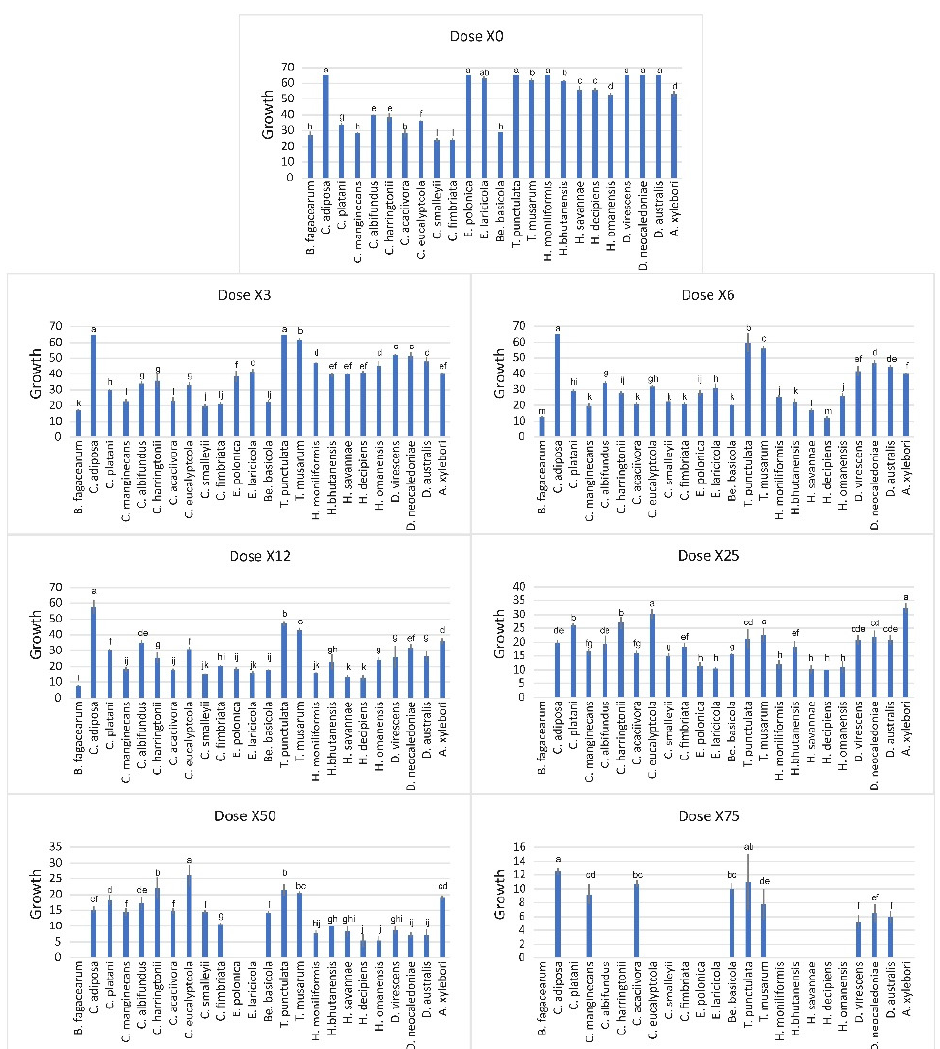
Figure 6. Effect of different triazole concentrations on mycelial growth of different Ceratocystidaceae including Ceratocystis ( C. manginecans , C. fimbriata , C. eucalypticola , C. harringtonii , C. smalleyii , C. albifundus , C. platani and C. adiposa ), Huntiella ( H. moniliformis , H. decipiens , H. bhutanensis , H. omanensis and H. savannae ), Thielaviopsis ( T. punctulata and T. musarum ), Bretziella ( Br. fagacearum ), Endoconidiophora ( E. polonica and E. laricicola ), Ambrosiella ( A. xylebori ), Davidsoniella ( D. virescens , D. neocaledoniae and D. australis ) and Berkeleyomyces ( Be. basicola ). Agar discs containing each isolate were grown for 7 days at 25 ◦ C on MEA media amended with triazole at six different concentrations. Bars represent standard error. There were significant differences between means ( p < 0.05) based on Tukey’s